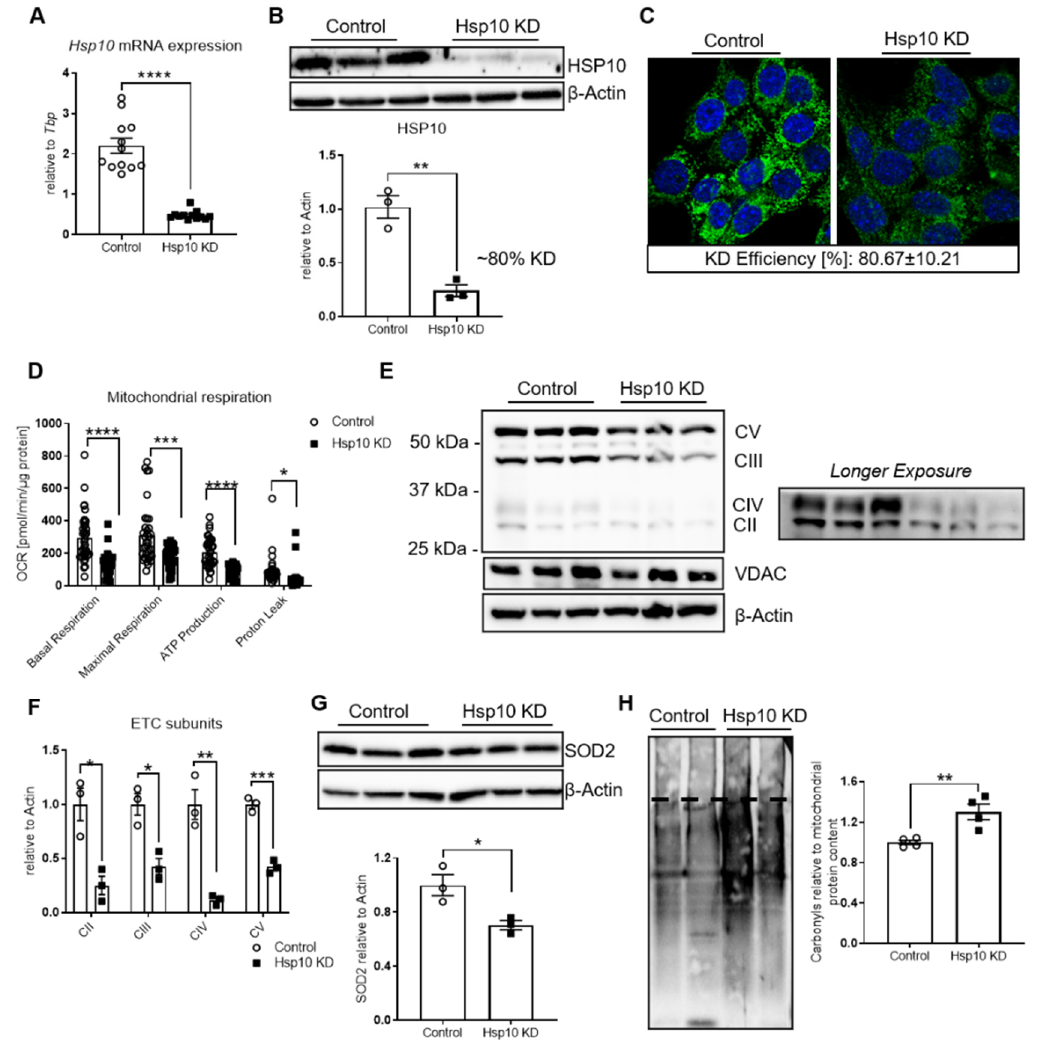
Figure 2. Lentiviral-induced KD of Hsp10 in hypothalamic cells induces mitochondrial dysfunction with mitochondria- specific oxidative stress. ( A ) mRNA expression of Hsp10 of control and Hsp10 KD CLU-183 cells, n = 12. ( B ) Protein expression of HSP10 and densitometric analysis, n = 3. β -Actin was used as loading control. Representative blot from three different experiments. ( C ) Representative pictures of immunofluorescence staining of control and Hsp10 KD cells. Green = Hsp10, blue = DAPI, n = 5–6 pictures per condition. ( D ) Analysis of bioenergetics profile of control and Hsp10 KD cells using the Seahorse Bioflux Analyzer XF96. n = 10–12 per condition. Normalization to total protein. ( E ) Protein expression of mitochondrial OXPHOS complex subunits of CII-CV of control and Hsp10 KD cells. VDAC served as a control for mitochondrial content, β -Actin served as a loading control n=3. (left) Representative blot from three independent experiments. (right) Longer exposure of the same representative blot for better illustration of expression of CII and CIV. ( F ) Densitometric analysis of Western blot shown in ( E ). ( G ) Protein expression of SOD2 and densitometric analysis, n = 3. β -Actin was used as loading control. Representative blot from three independent experiments. ( H ) Representative Western blot (2 vs. 2) and densitometric analysis (4 vs. 4) of protein carbonylation of the mitochondrial fraction of control and Hsp10 KD cells. Representative blot from two different experiments, n = 4. *, p < 0.05, **, p < 0.01, ***, p < 0.001, **** p < 0.0001 after two-tailed Student’s t-test. All data are presented as mean ± SEM.